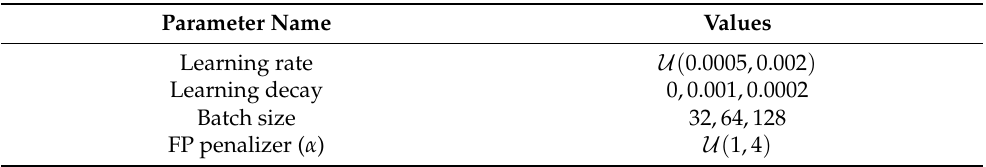
Table 2. Hyper-parameter search constraints for Bayesian optimization during training of neural